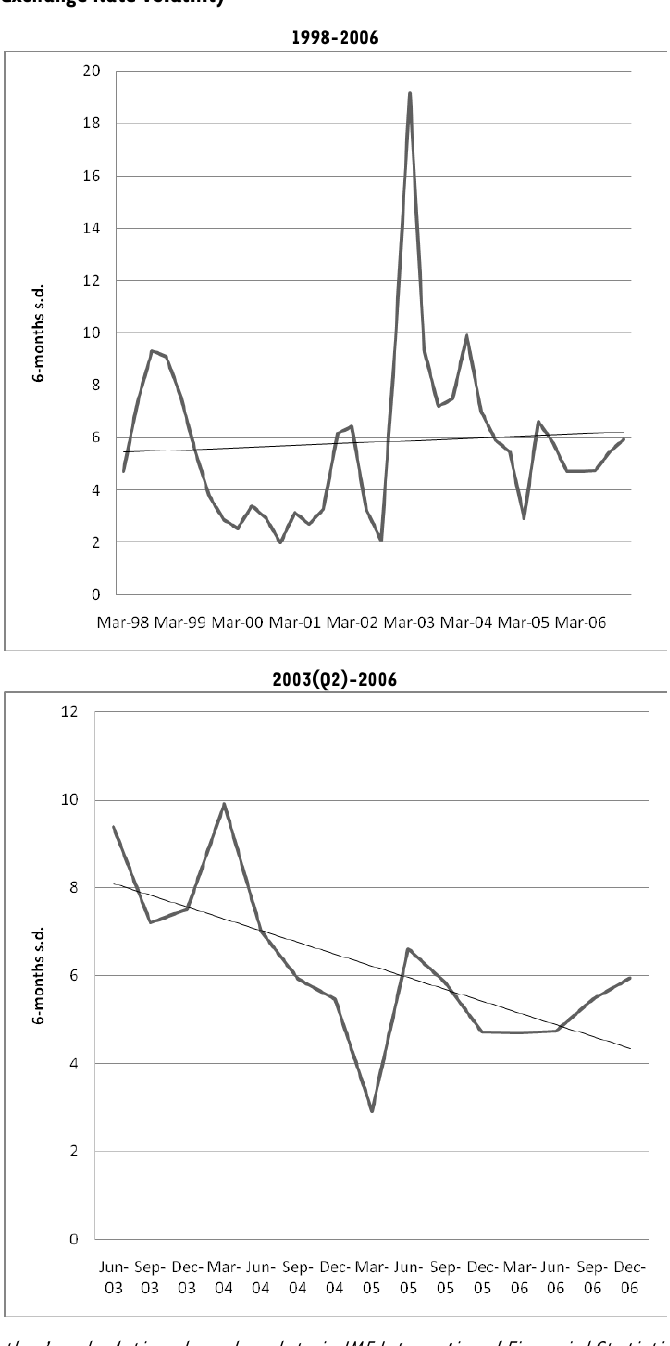
FIGURE 9: Exchange Rate